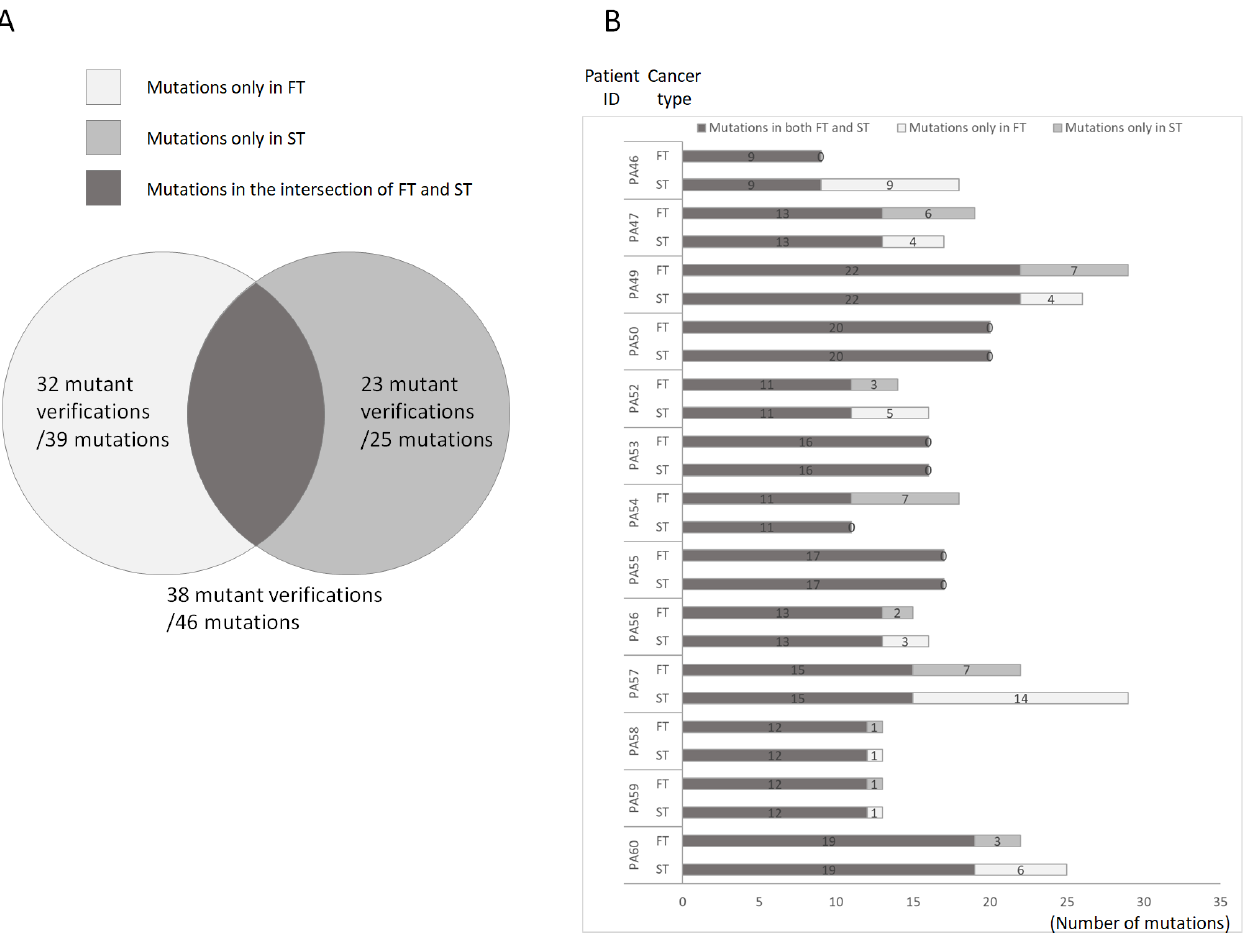
Figure 2. Schematic of the distribution of mutations in first and second primary tumors. ( A ). Overview of mutations in first and second tumors. Only first primary tumor showed 39 mutations (White). We verified 32 of the 39 mutations. Only second primary tumor showed 25 mutations (gray). We verified 23 of the 25 mutations. Both first and second primary tumors showed 46 mutations (black). We verified 38 of the 46 mutations. ( B ). Distribution of mutations in patients. This bar chart shows mutations in first primary tumor (white), second primary tumor (gray), and first and second primary tumors (black). The number in the bar shows the number of mutations.